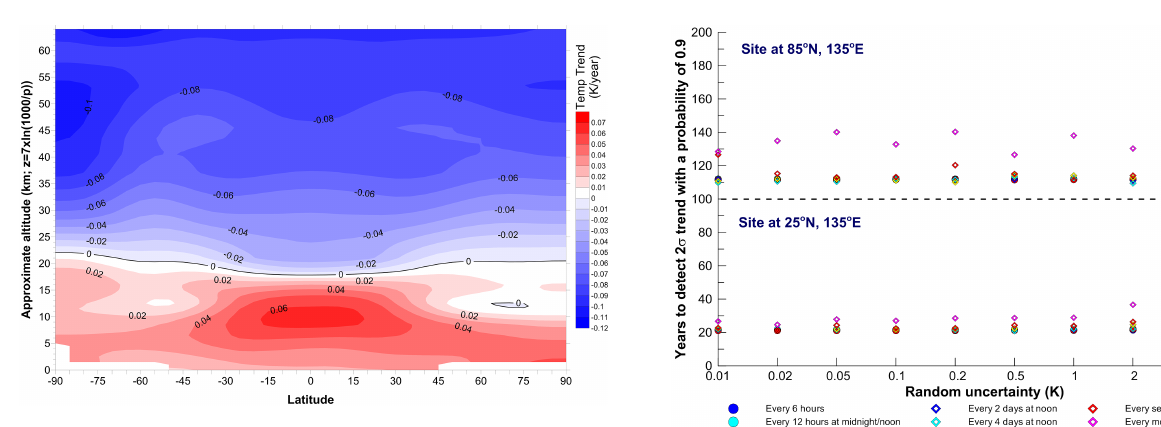
Figure 6. Projected trends in upper-air temperatures for 2000–2099 from 11 chemistry–climate models running the REF-B2 simulation from CCMVal-2.